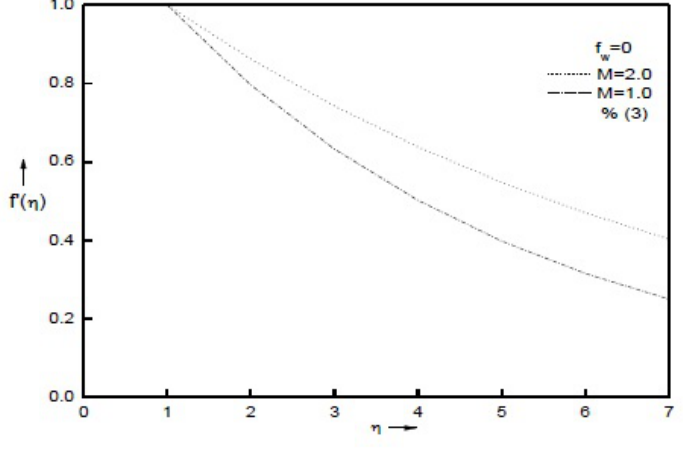
Fig. 3 Velocity profiles f (cid:48) ( η ) for various values of magnetic parameters M for f w = 0.